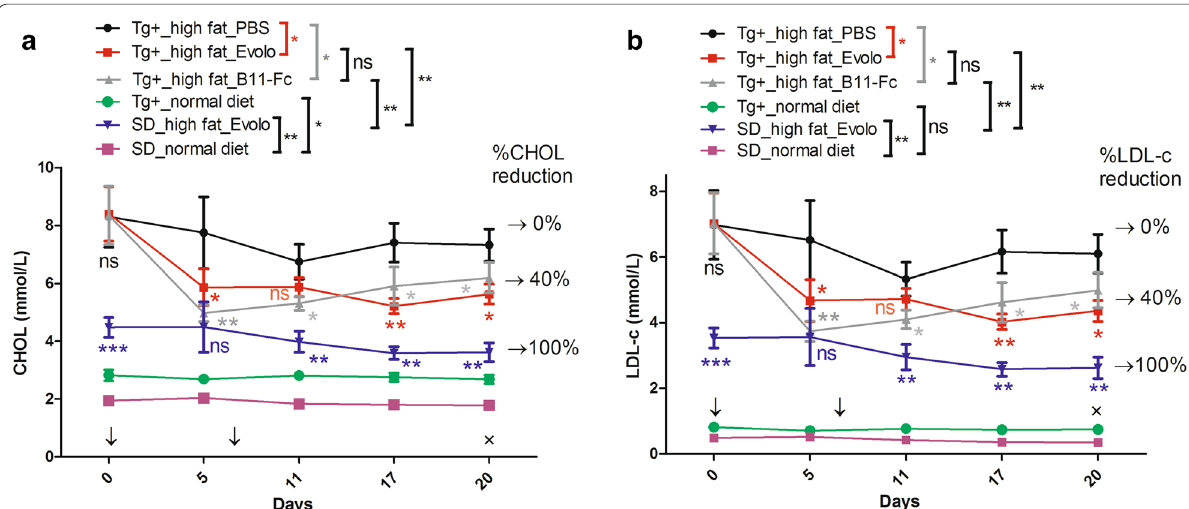
Fig. 7 The pharmacodynamics assay in the hPCSK9 transgenic rat model. The horizontal axis represents the timeline (days post the first treatment). The vertical axis represents the CHOL (A), LDL-c (B) levels (mmol/L) and their percent change (%) was given on the right ( Sprague Dawley rat. ‘Tg ’ represents the hPCSK9 transgenic SD rat; ‘high fat’ refers to the feeding of the high fat diet to the rat. ‘Evolo’ represents + the rat treated with the evolocumab. ‘PBS’ represents the rat injected with the PBS buffer. ‘ ‘ ’ represents the sacrifice of the animals on day 20. P < 0.05 was considered as statistically significant, compared with the PBS group (* P < 0.05, × ** P < 0.01; ns: not